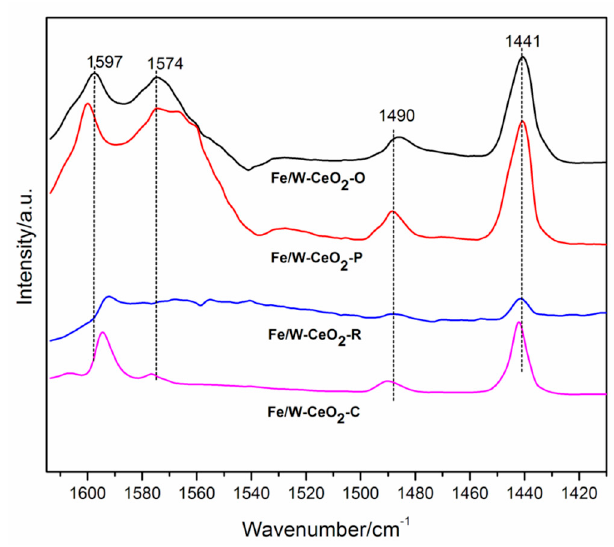
Figure 7. Py-IR spectra of four Fe/W–CeO 2 catalysts.